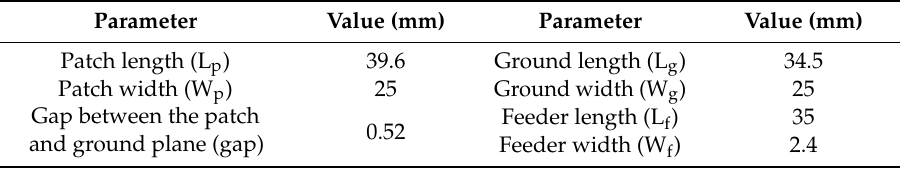
Figure 14. UWB antenna ( a ) geometry and ( b ) fabricated circuit. Table 3. UWB antenna design